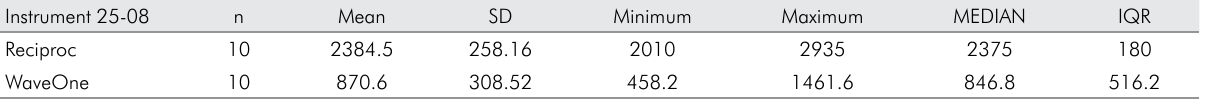
Table 2. Statistical descriptions of the NCFs observed for the instruments in the static test groups.